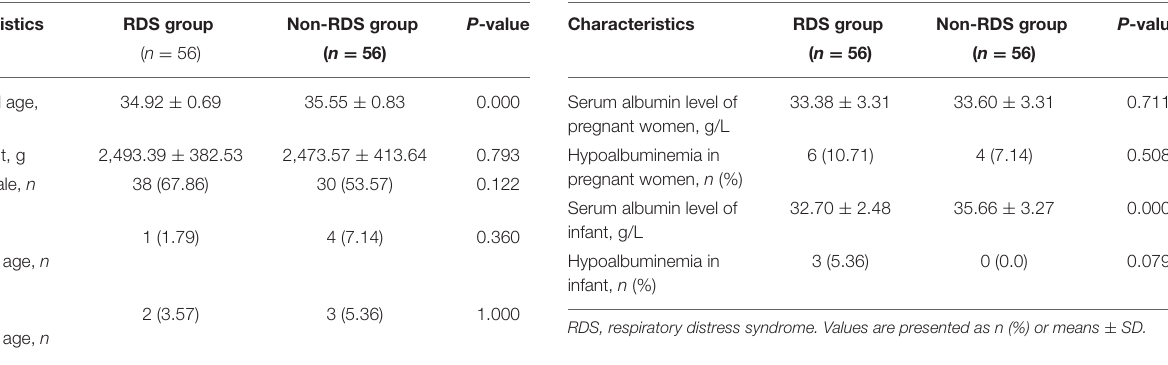
TABLE 4 | Maternal-neonatal serum albumin level of the two group.